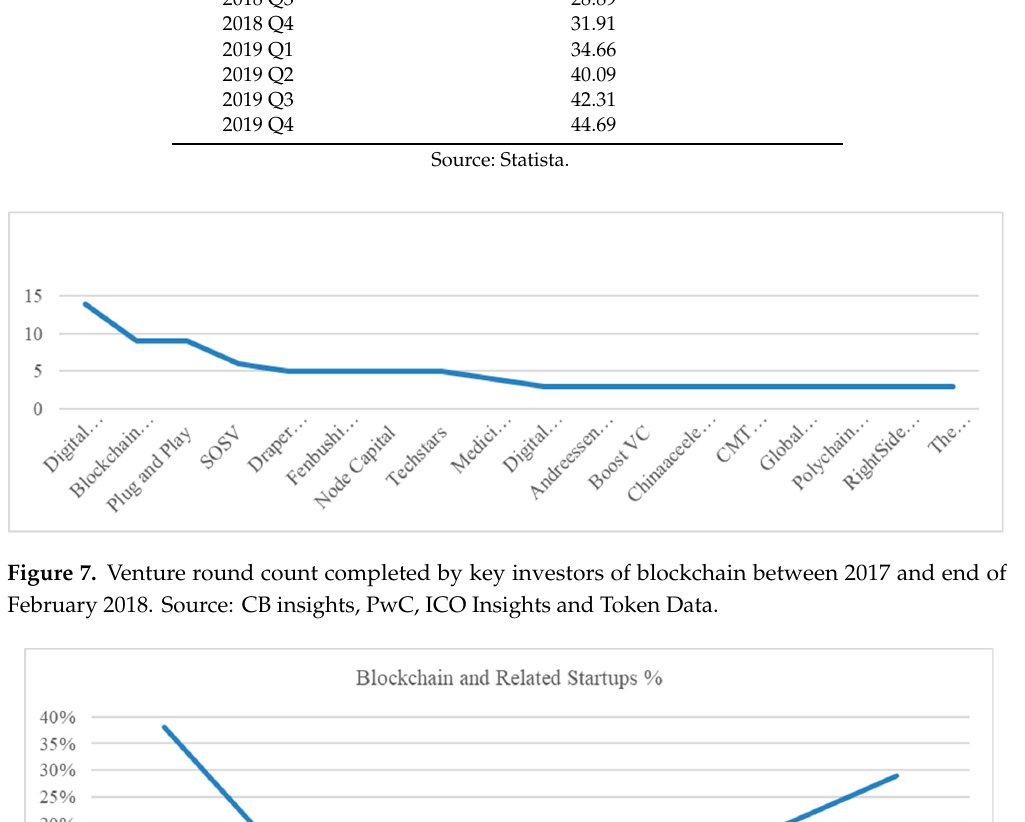
Figure 9. Blockchain Technology investment by different categories. Source: CB insights, PwC, ICO Insights and Token Data. Figure 10. Number of blockchain technology deals by different categories. Source: CB insights, PwC, ICO Insights and Token Data.